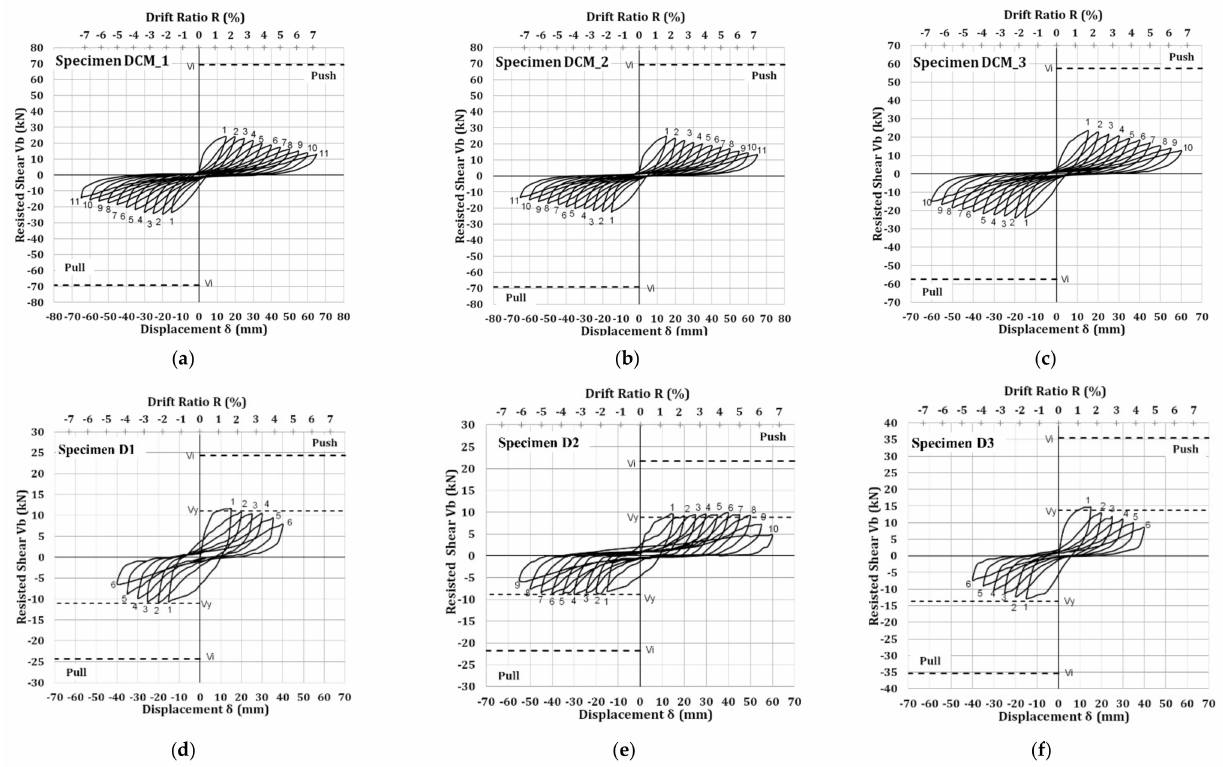
Figure 3. Plots of shear resisted force versus displacement of the beam–column joint subassemblages of modern RC structures: ( a ) specimen DCM _1; ( b ) specimen DCM _2; ( c ) specimen DCM _3 and of existing pre-1960s–1970s RC structures; ( d ) specimen D 1; ( e ) specimen D 2; ( f ) specimen D 3.